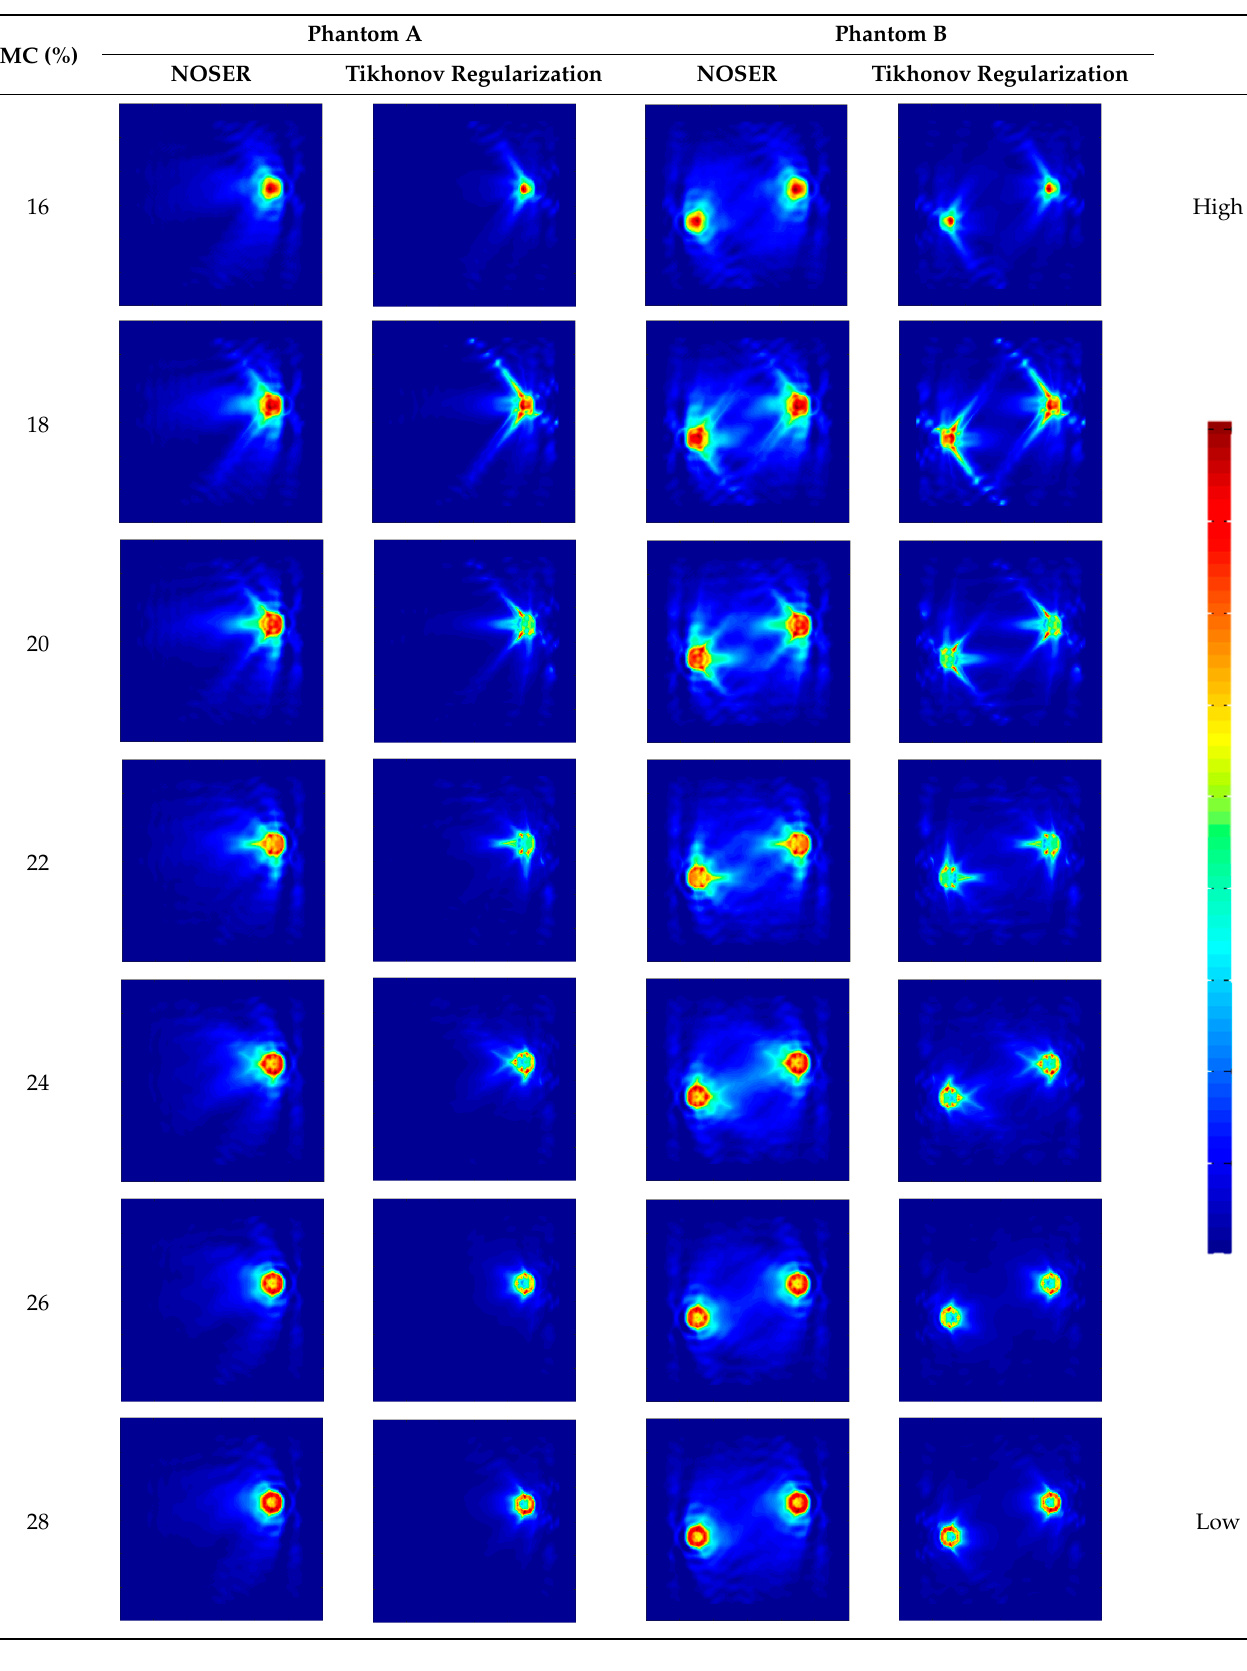
Table 2. Reconstructed images for Phantoms A and B at different percentages of MC.